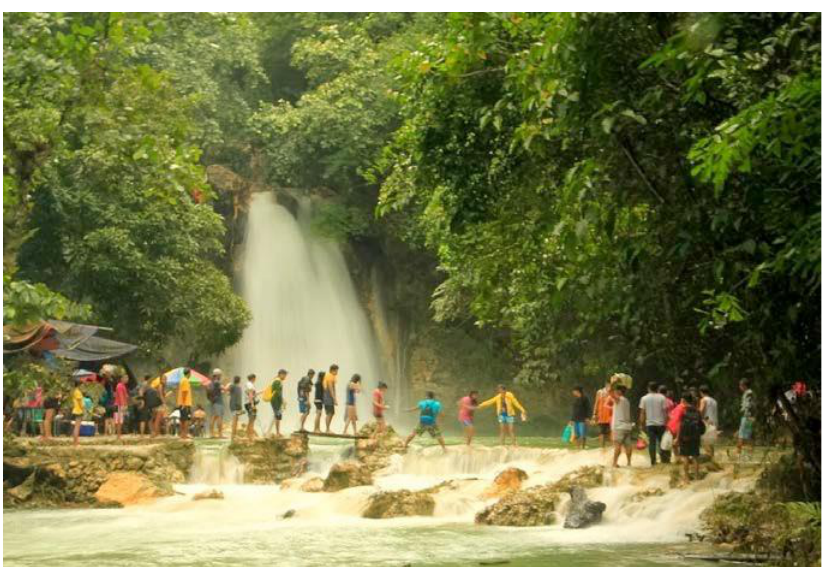
Figure 7. The passway of Kawasan which are made up of big rocks reached by flowing